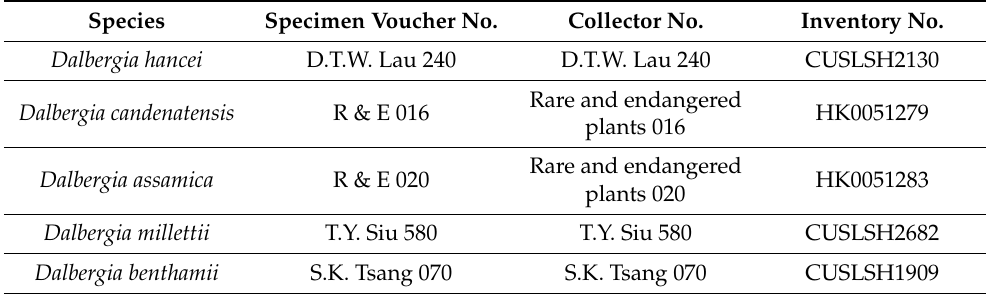
Table 4. Information of the studied specimens. Species Specimen Voucher